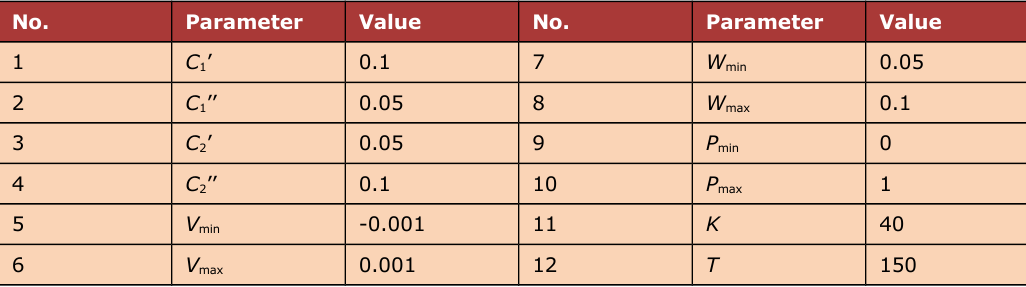
Table 3. Parameter setting of PSO